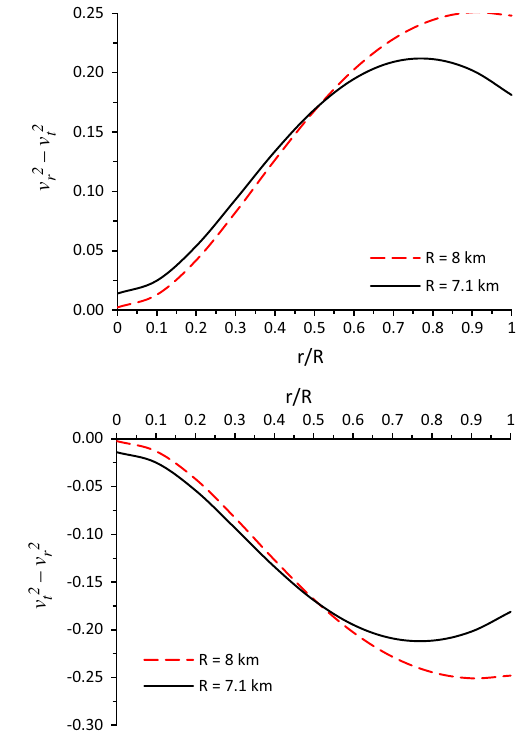
Fig. 7 Behavior of v 2 r − v 2 t and v 2 t − v 2 r versus radial coordinates r / R . For plotting of this figure, the corresponding values of arbitrary constants or parameters are displayed in Table